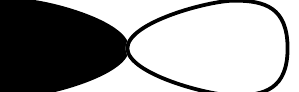
Figure 4. A representation of an orbital, which houses the electrons in a double bond.